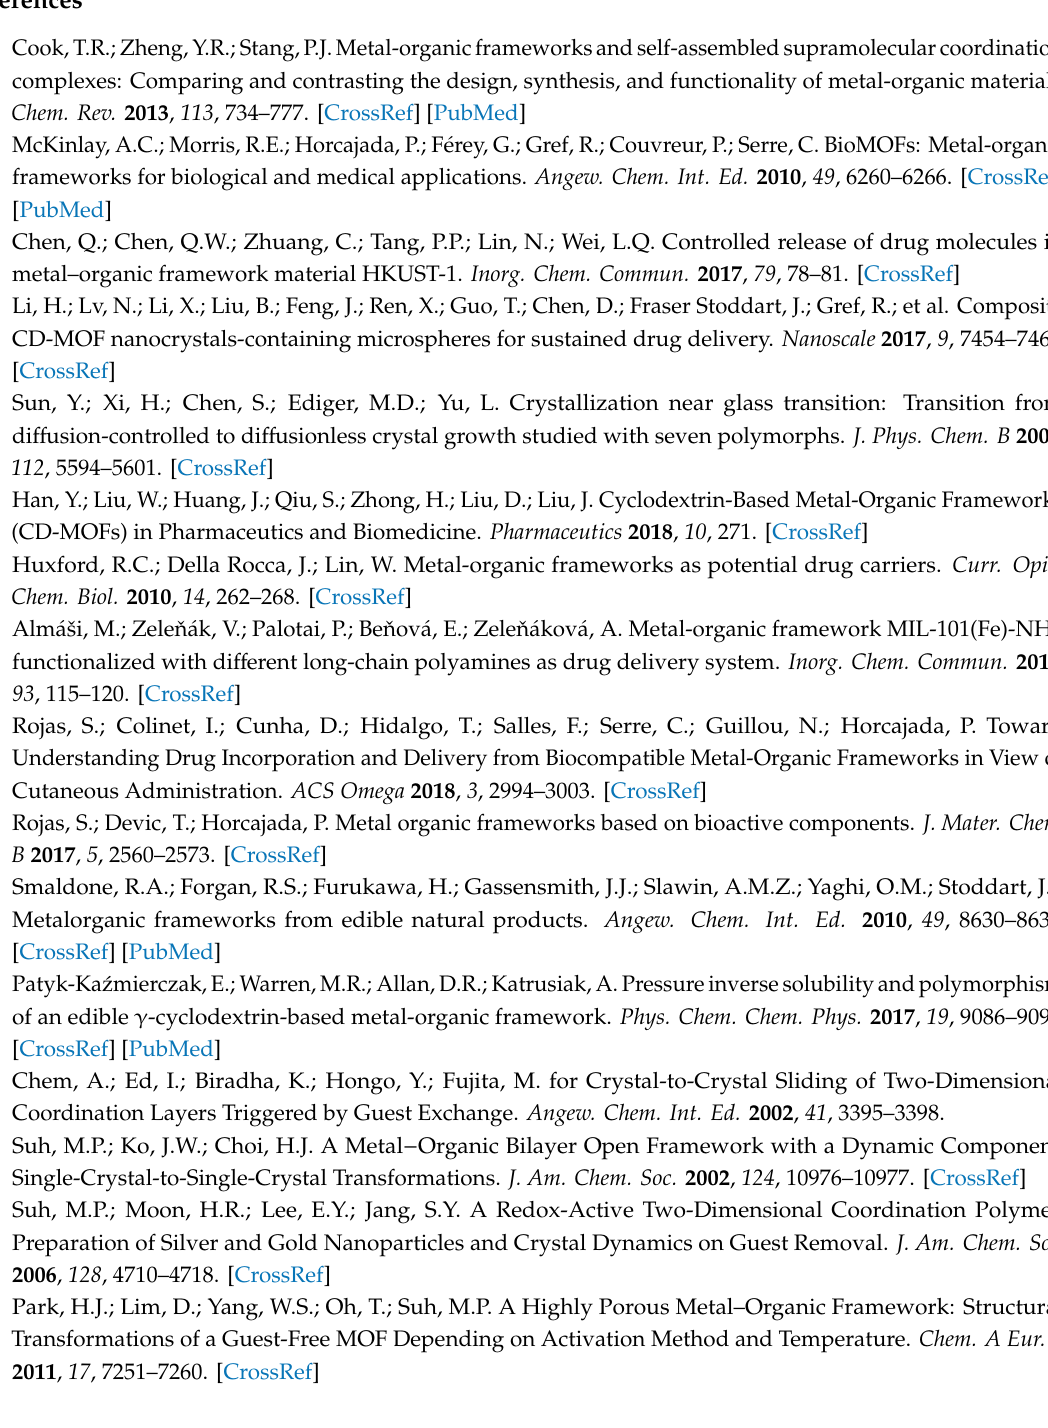
Table S8: Measured lattice parameter of γ -CD-MOF-1 in diethyl